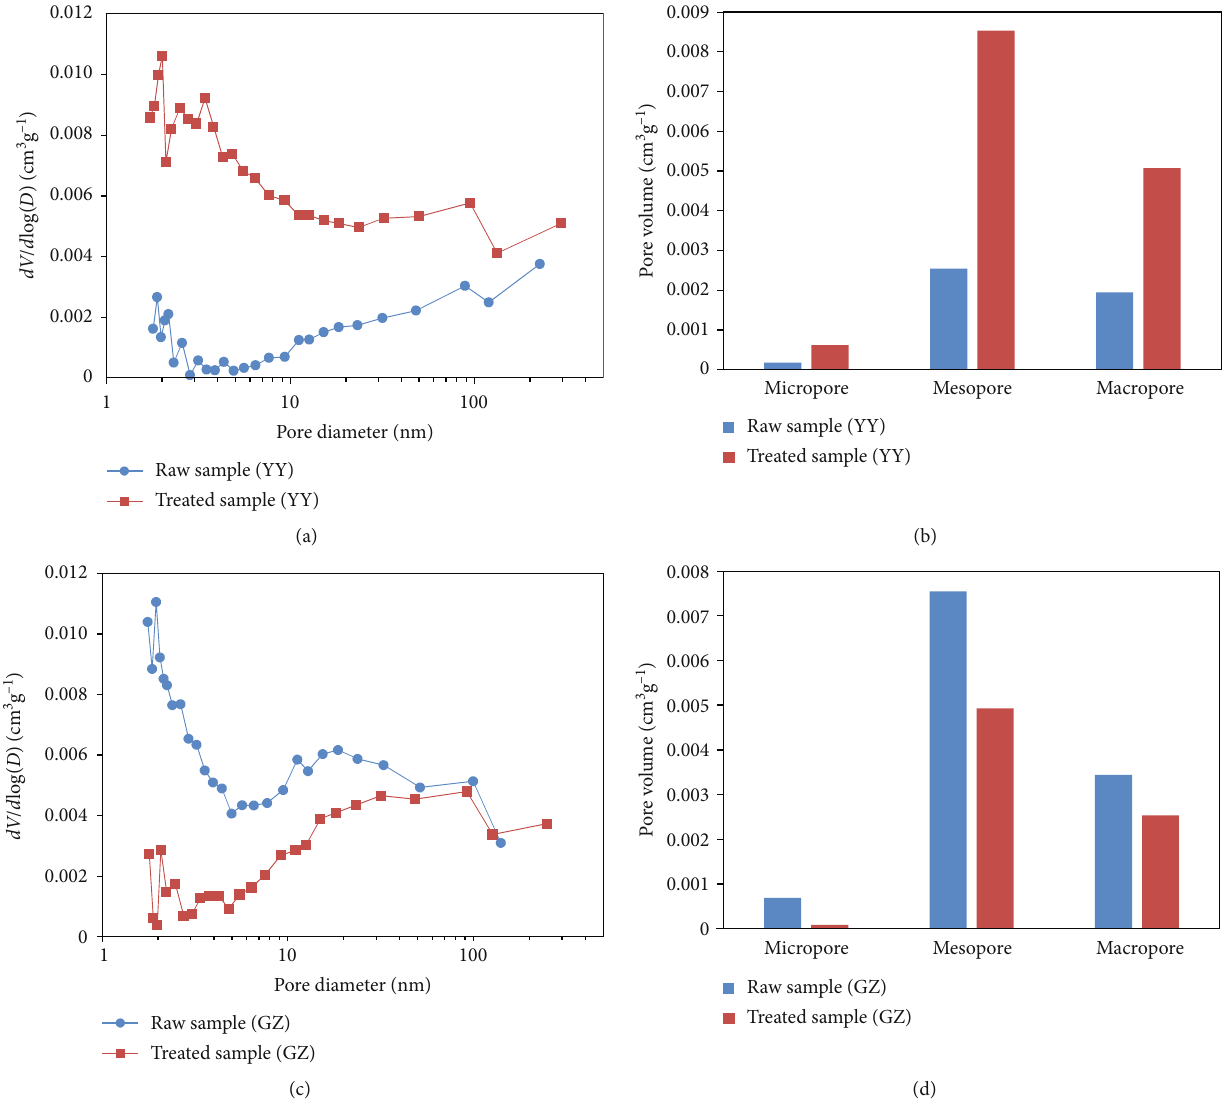
Figure 7: Pore size distributions (a, c) and pore volume values (b, d) for each type of pores for the raw and treated shale samples: (a, b) YY; (c, d)